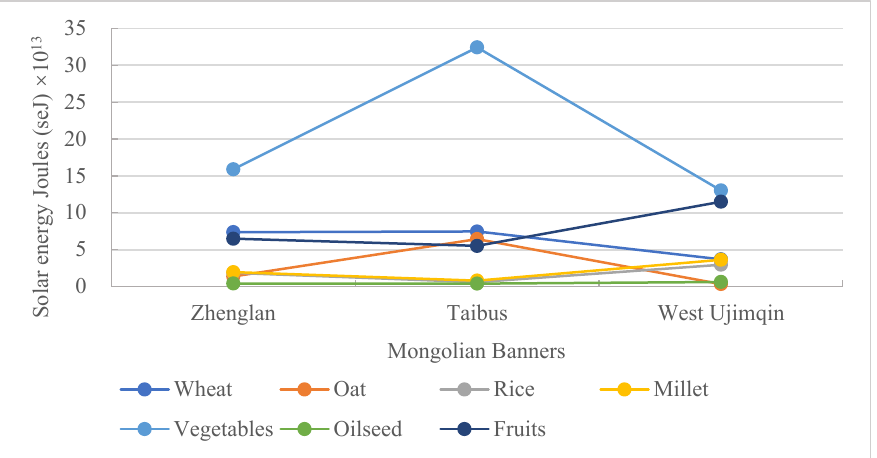
Figure 4. A comparison of plant-based food consumption in the three banners.